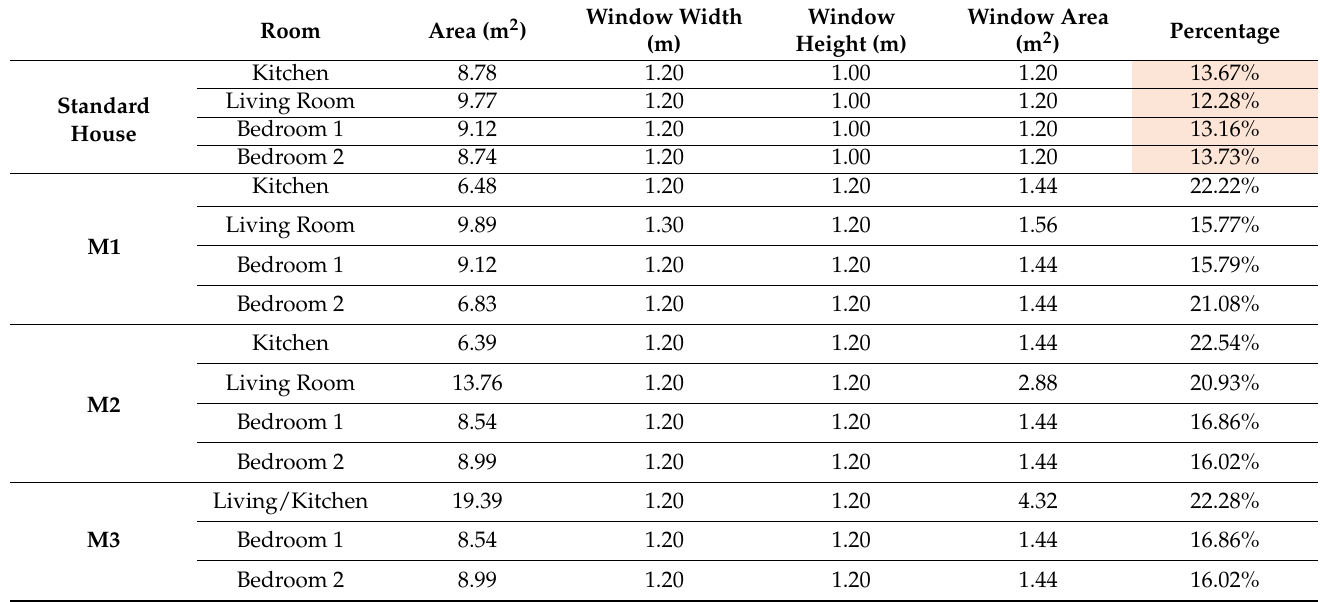
Table 6. Effective ventilation openings for rooms where residents spend extended amounts of